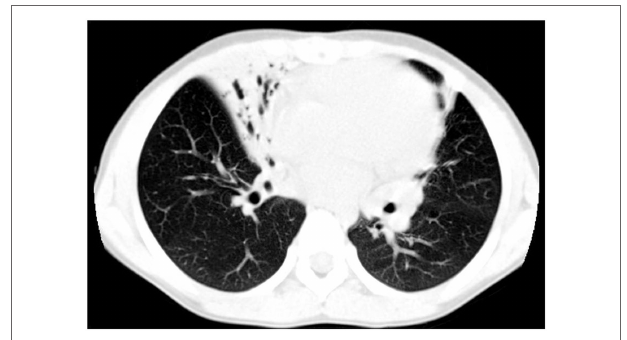
FiGURe 2 | High-resolution computed tomography findings from a 7-year-old girl with primary ciliary dyskinesia. The scan demonstrates an area of consolidation both in the lingula and in the middle lobe, the latter also including